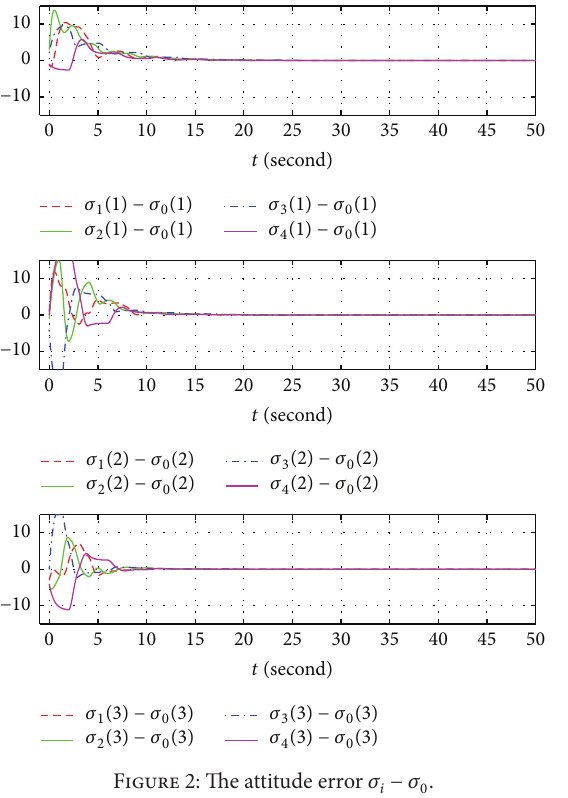
Figure 4: The auxiliary vector error 𝑠 𝑖 − 𝑠 0 .